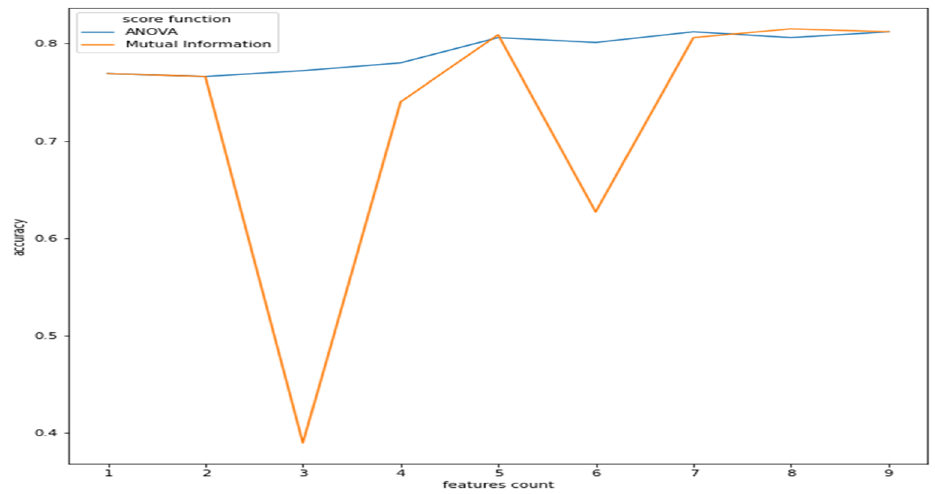
Figure 5. Features count vs. accuracy (ANOVA and MI).